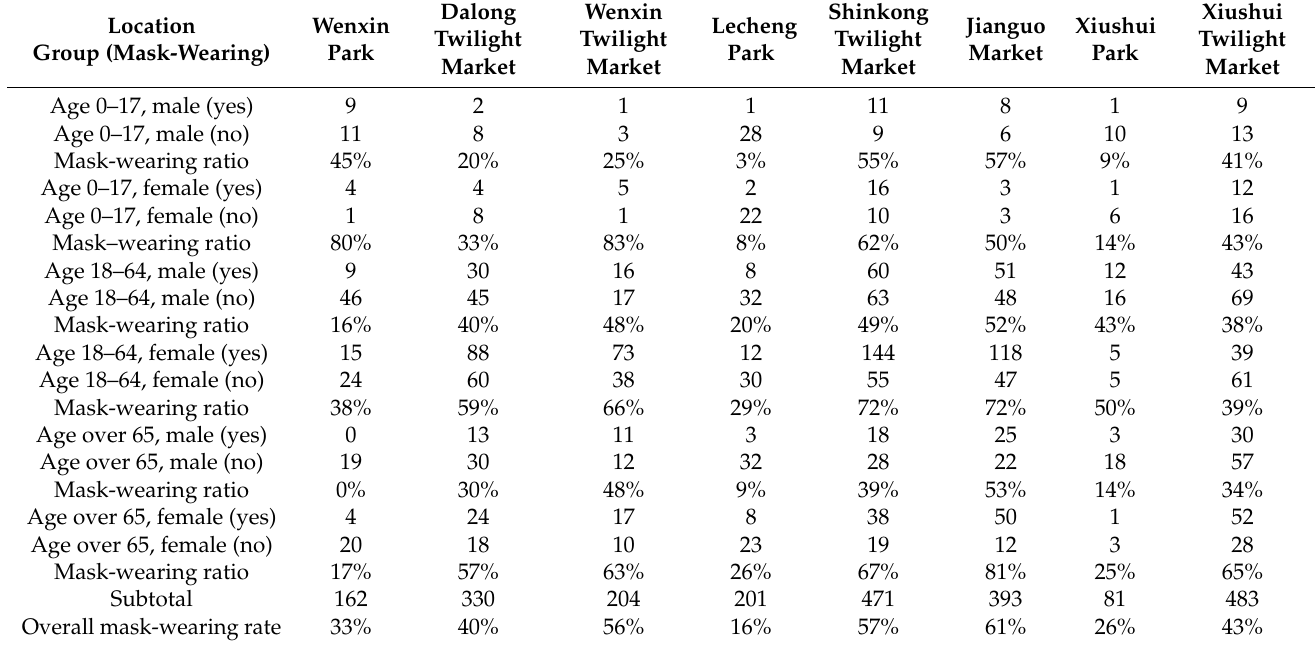
Table 2. Rates of mask-wearing, first observation, by estimated demographic group.